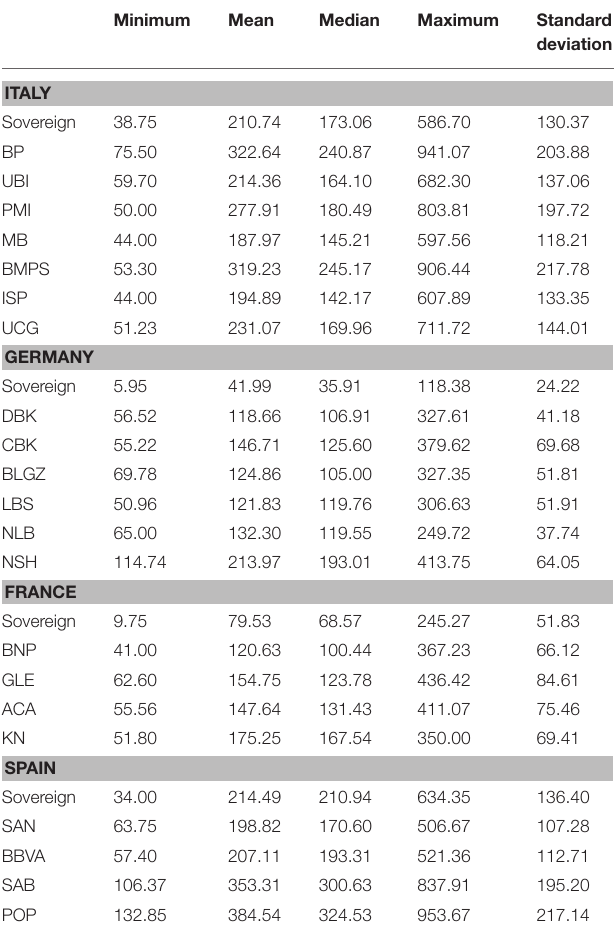
TABLE 1 | Summary statistics of the CDS spreads with maturity 5 year between June 30, 2008 and December 31, 2014 for the four sovereign and the 21 banks considered in the empirical